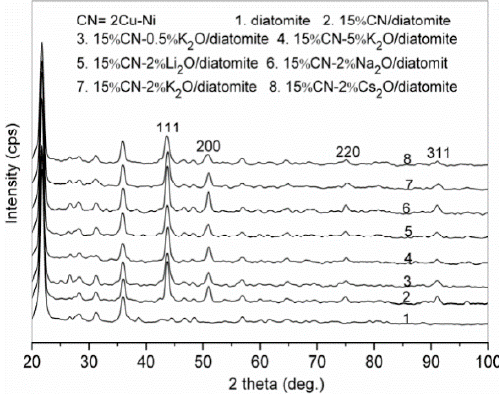
Figure 4. Powder X-ray diffraction (XRD) of the samples.